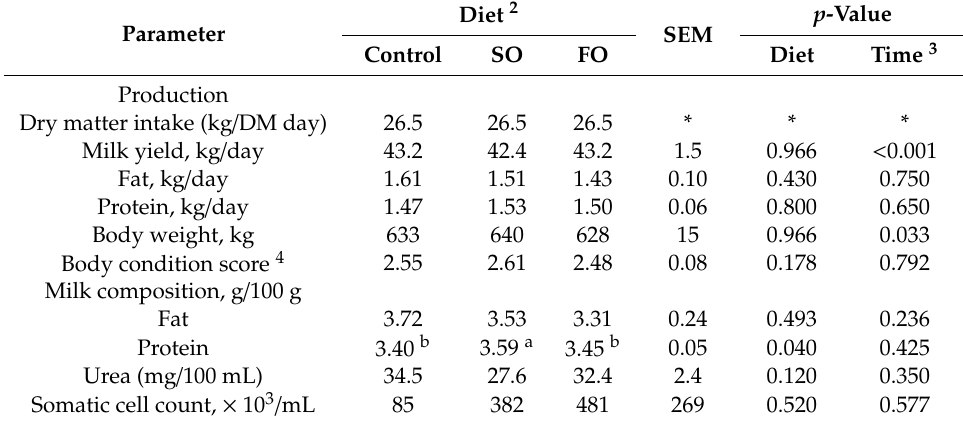
Table 2. Performance and proximate analysis of milk from cows supplemented with control, soybean oil (SO), and fish oil (FO) 1